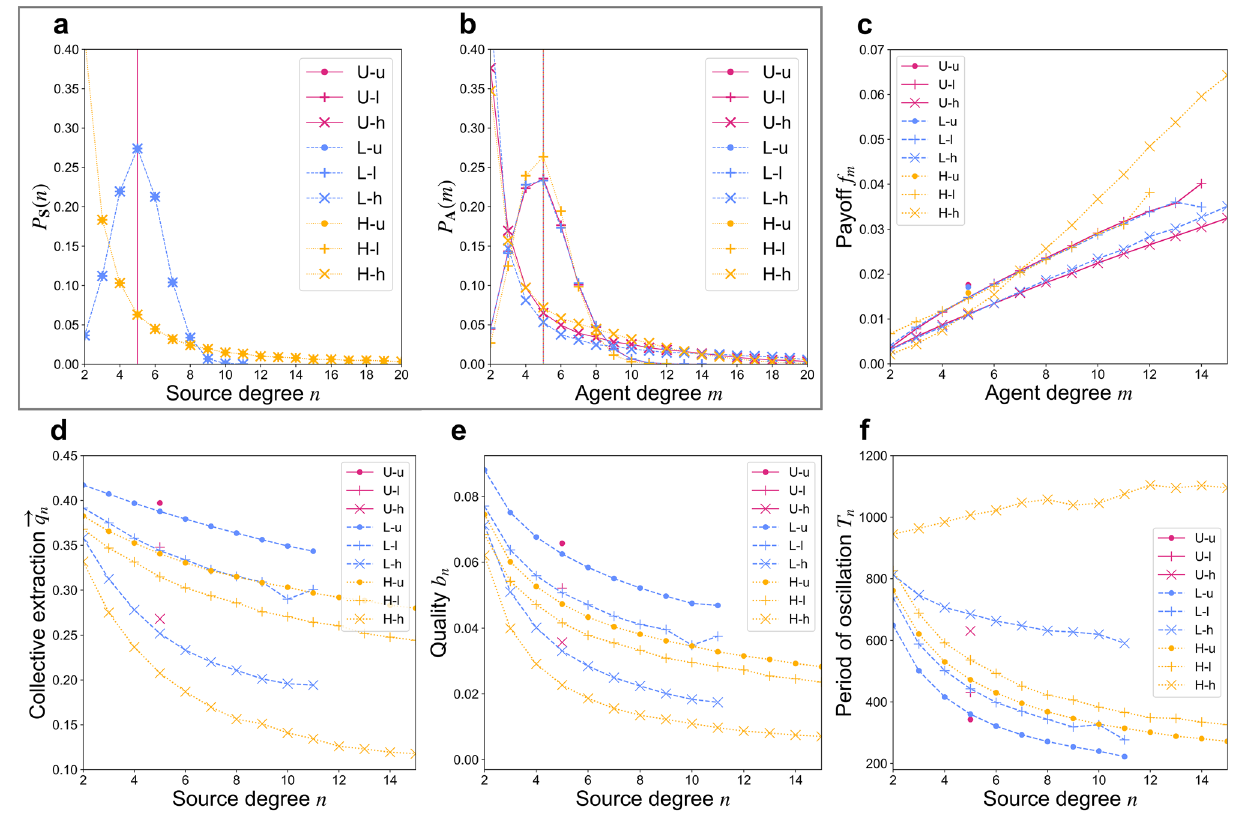
Figure 2. ( a ) Source degree distributions and ( b ) Agent degree distributions for 9 network ensembles, each representing a combination of a Uniform-degree (U), Low-heterogeneity (L), or High-heterogeneity (H) source degree distribution with a uniform-degree (u), low-heterogeneity (l), or high-heterogeneity (h) agent degree distribution. Ensemble mean time-averaged quantities from pure free adaptation dynamics: ( c ) Agent payoffs −→ f ( a ) as a function of agent degree m ( a ) ; ( d ) Collective extraction q ( s ) as a function of source degree n ( s ) ; ( e ) Source quality b ( s ) as a function of source degree n ( s ) ; and ( f ) Period of oscillation T ( s ) as a function of source degree n ( s ) . Means are computed from simulations on 10 3 networks of each